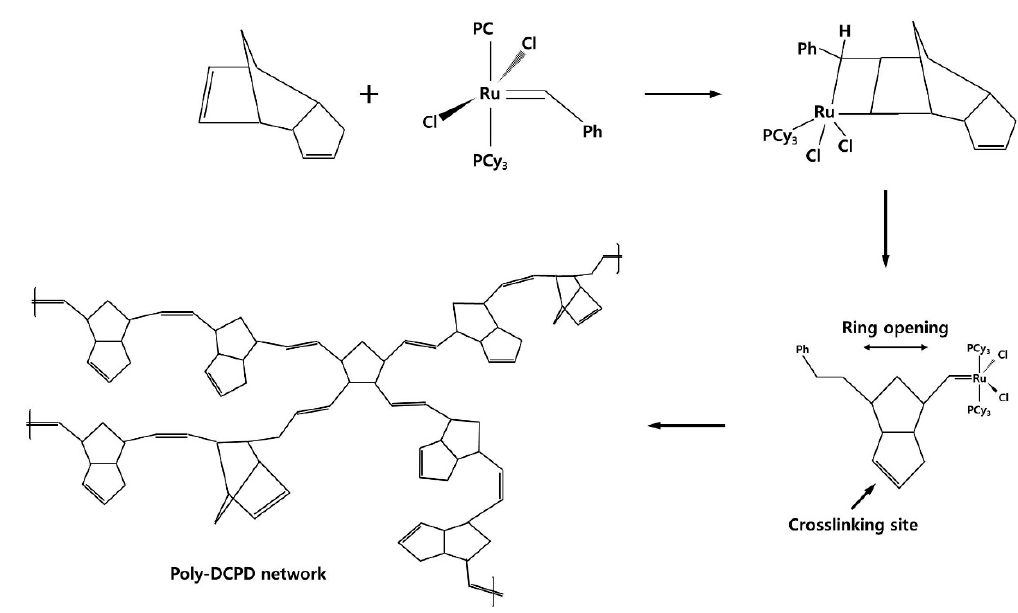
Figure 1. The polymerization of dicyclopentadiene (DCPD) with Grubbs catalyst [17]